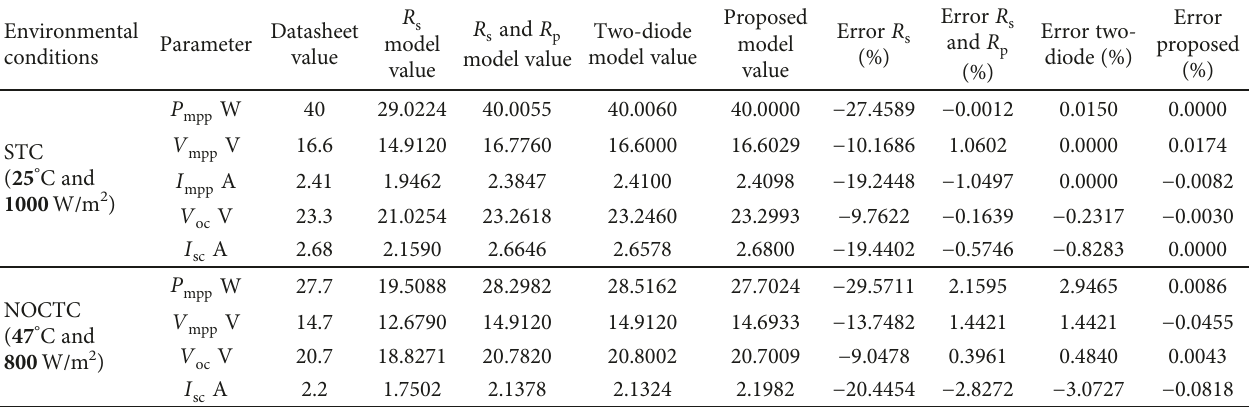
model, R and R model, two-diode model, and proposed model output with manufacturer ’ s datasheet for Shell s s p